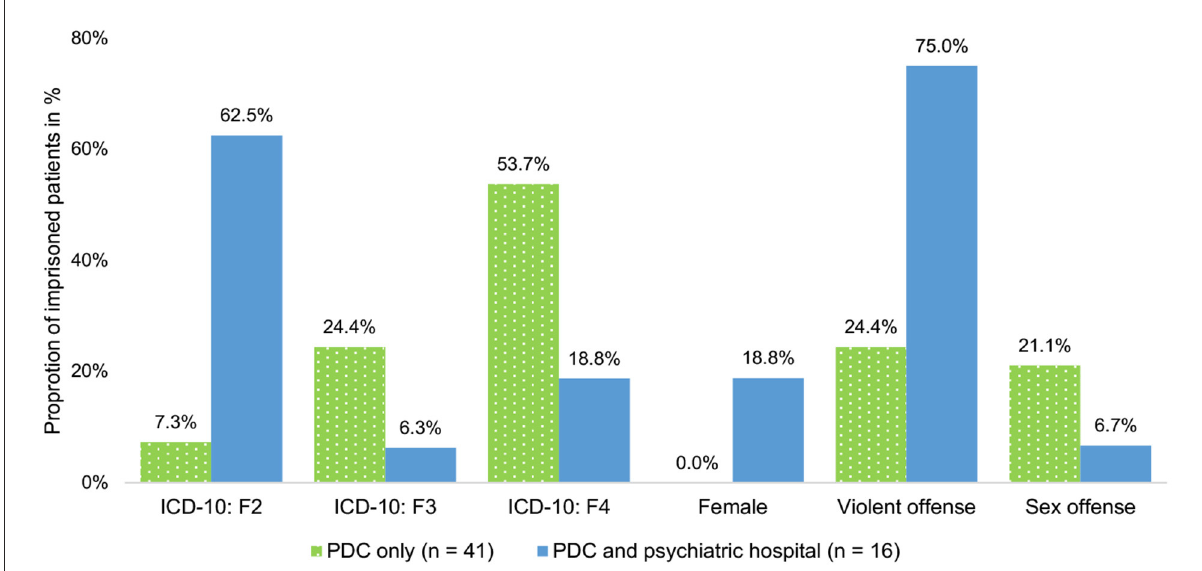
FIGURE1 Comparing characteristics of individuals treated only in the psychiatric day clinic with patients treated in both the psychiatric day clinic as well as a psychiatric hospital.